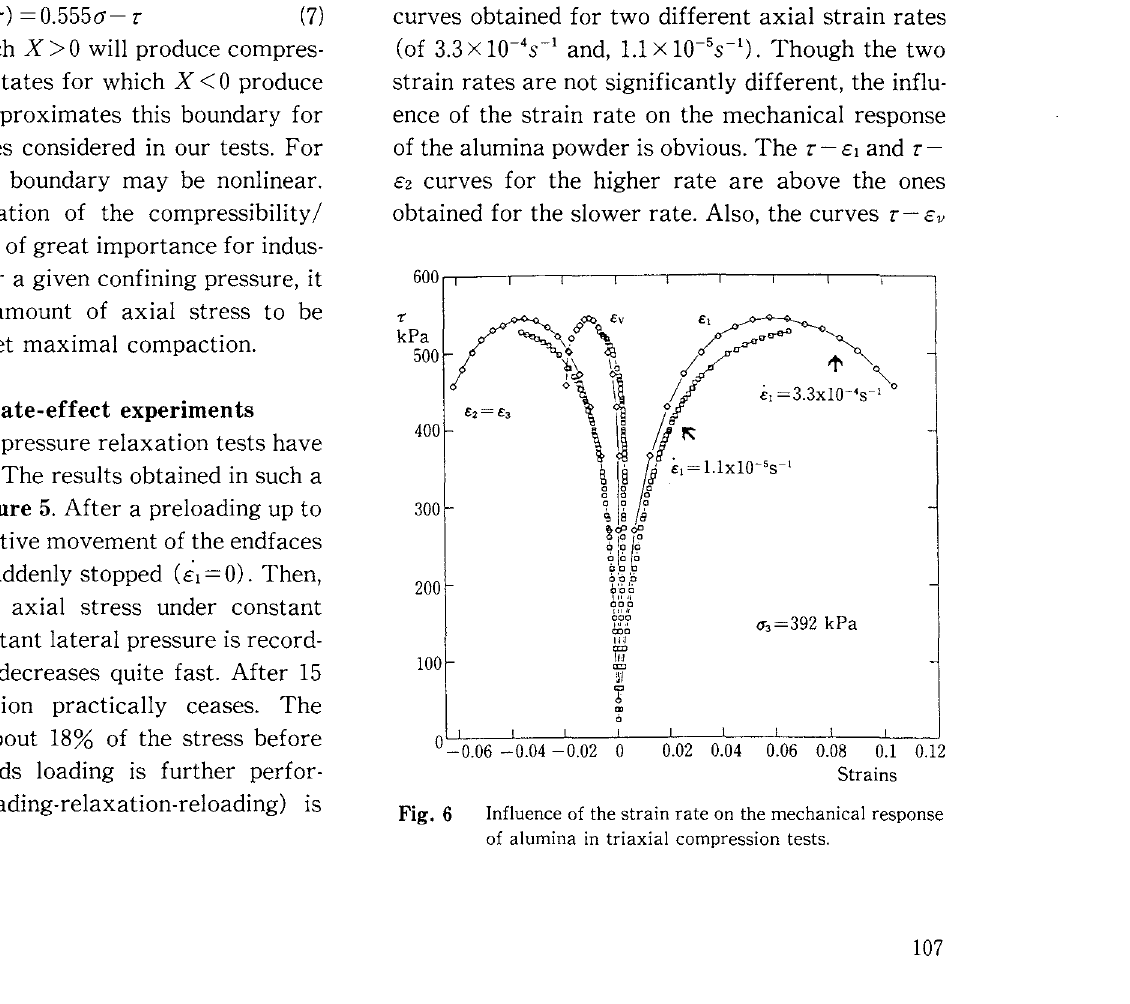
Influence of the strain rate on the mechanical response of alumina in triaxial compression